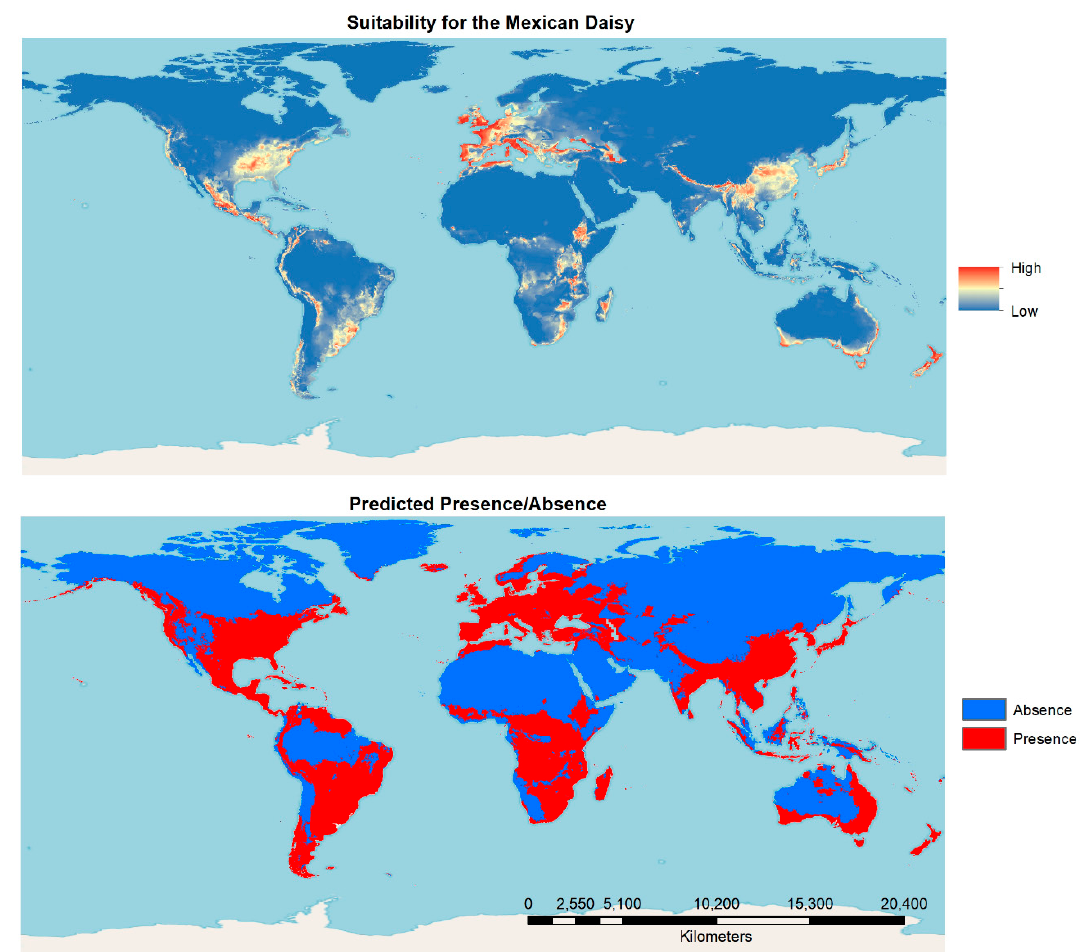
Figure 4. Results of suitability mapping and prediction of presence absence using Maxent for the 100 km rarefied occurrence data and non-correlated variables.